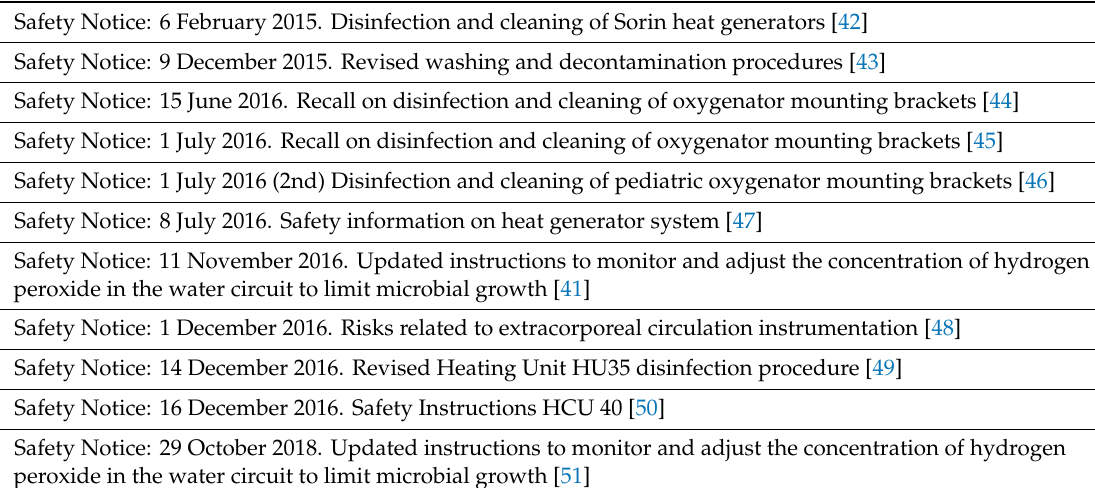
Table 1. List of safety notices issued in Italy on the dissemination of MC by